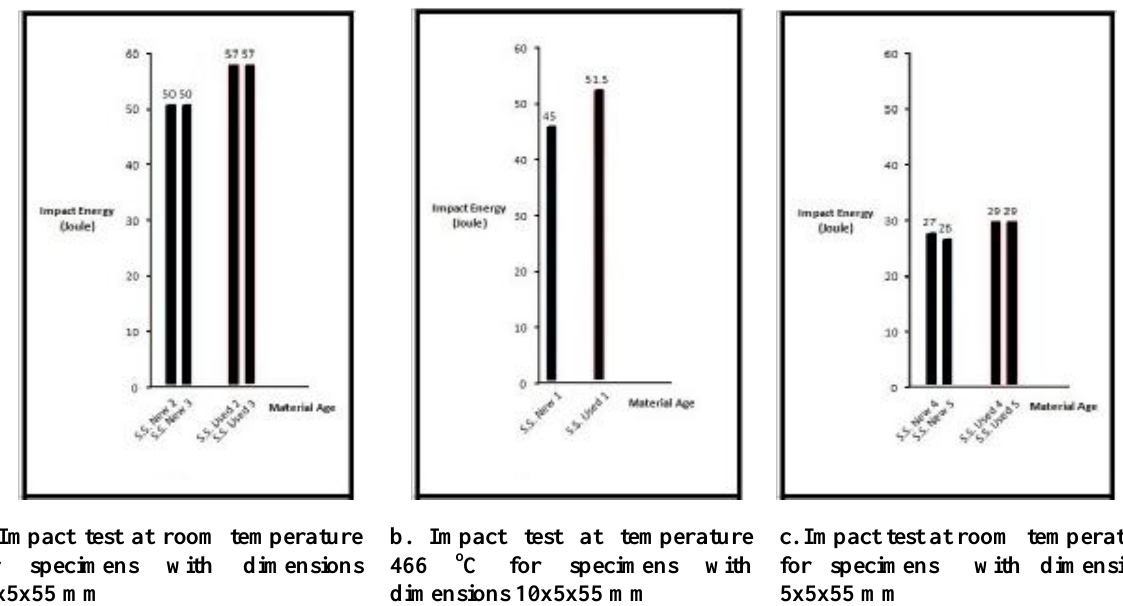
Fig. 4 Impact energy comparison between un-used and ex-used stainless steel tube samples (SA-312TP321H)